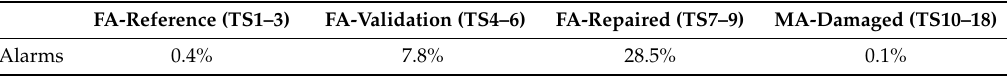
Figure 10. The Novelty Indices computed via Mahalanobis Distance. The MC threshold is visualized in red. The different acquisitions are separated by the black dotted lines and ordered according to their corresponding TS number. The healthy calibration data are separated from the healthy validation data, from the repaired validation data and from the damaged validation data by the black dash-dot lines. Table 3. The MD-NI damage detection performance: False Alarms (FA) and Missed Alarms